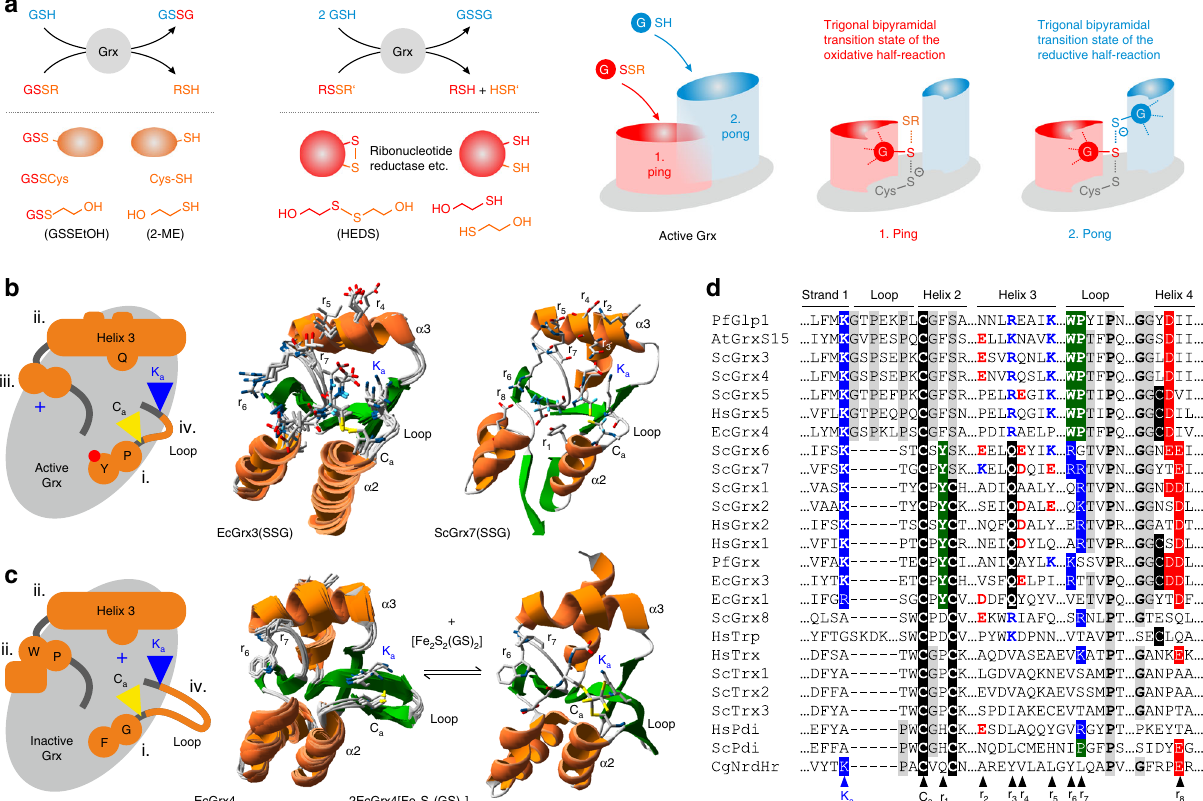
Fig. 1 Structural differences between enzymatically active and inactive Grx. a Enzymatically active glutaredoxins (Grx) use reduced glutathione (GSH) as an electron donor for the reduction of high- and low-molecular weight glutathione disul fi de substrates (GSSR) or non-glutathione disul fi de substrates (RSSR ’ ) as highlighted in the left half of the panel. The Grx-catalyzed reduction of GSSR by GSH is separated into an oxidative and reductive half-reaction as highlighted by the two predicted transition states and glutathione interaction sites in the schematic representations in the right half of the panel. b Structure of enzymatically active Grx. A schematic representation of four specialized protein areas, NMR solution structures of the glutathionylated C14S mutant of enzymatically active EcGrx3 (PDB entry 3GRX), and a model of glutathionylated ScGrx7 are shown from left to right. Please note that the glutathione moiety as well as the conserved active-site cysteine (C a ) and lysine (K a ) residue adopt several alternative positions in the NMR structures. c Structure of enzymatically inactive Grx. A schematic representation of four specialized protein areas, NMR solution structures of enzymatically inactive EcGrx4 (PDB entry 1YKA), and the crystal structure of EcGrx4 in complex with an iron – sulfur cluster (PDB entry 2WCI, one EcGrx4 subunit and one GS − ligand were omitted for clarity) are shown from left to right. Please note the conformational change of the elongated loop and the repositioning of the active-site cysteine and lysine residue upon iron – sulfur cluster binding. d Sequence alignment of glutaredoxin isoforms and comparison with other proteins of the thioredoxin superfamily from A. thaliana (At), S. cerevisiae (Sc), Homo sapiens (Hs), E. coli (Ec), P. falciparum (Pf), and C. glutamicum (Cg). Established as well as potential glutathione-interacting residues r 1 – 8 are